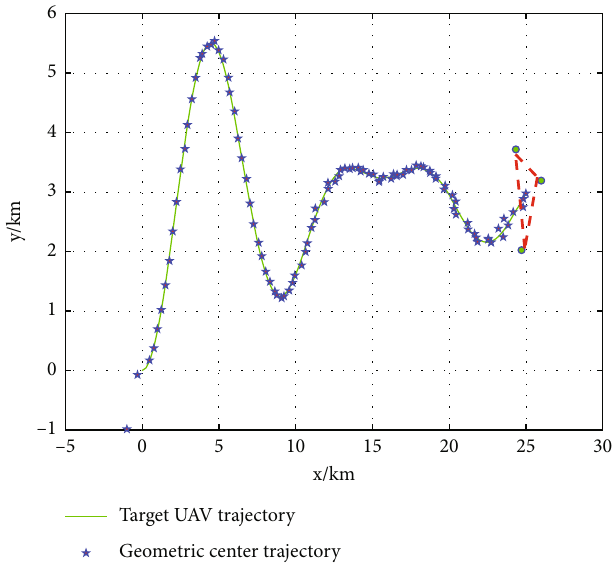
Figure 5: The geometric centre trajectory of traditional